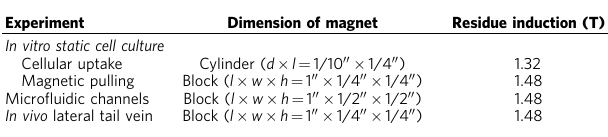
Table 1 | The properties of magnets used in in vitro and in vivo